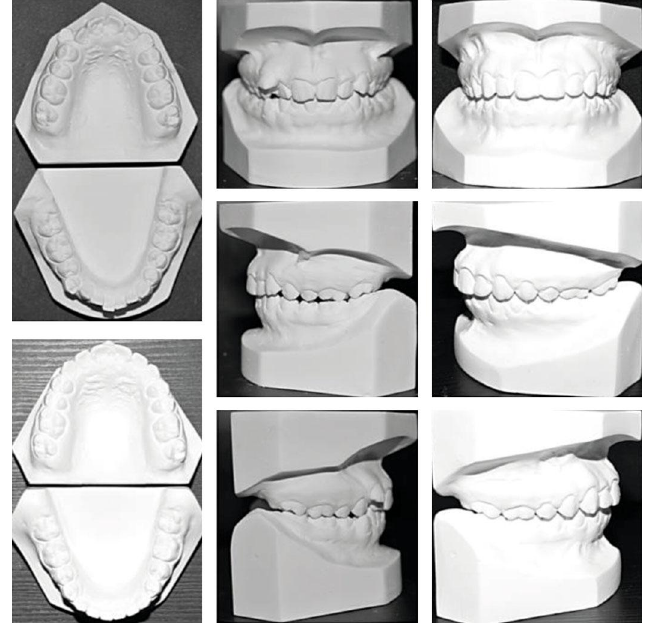
Figure 6: Initial and fi nal study